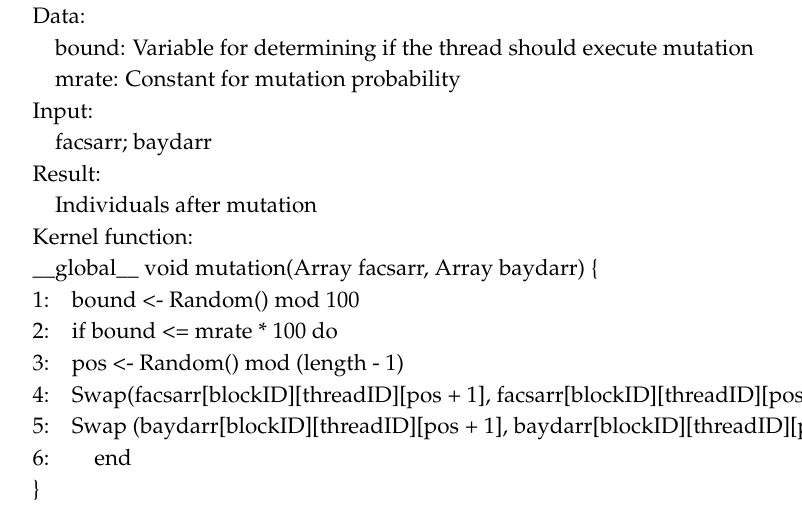
Algorithm 4: Parallel Mutation Operator